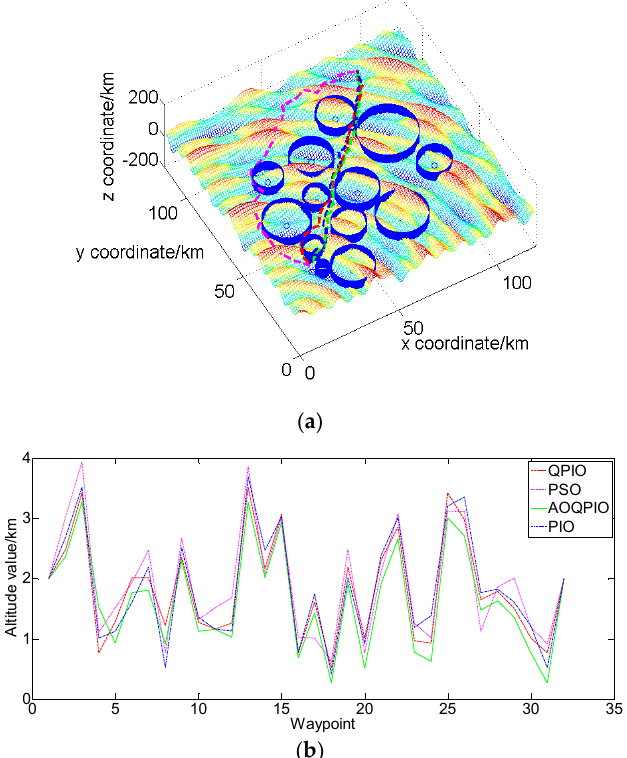
Figure 3. ( a ) is the result of all algorithms and ( b ) is the result of optimal unmanned aerial vehicle (UAV) altitude of the experiment carried out in map 2.